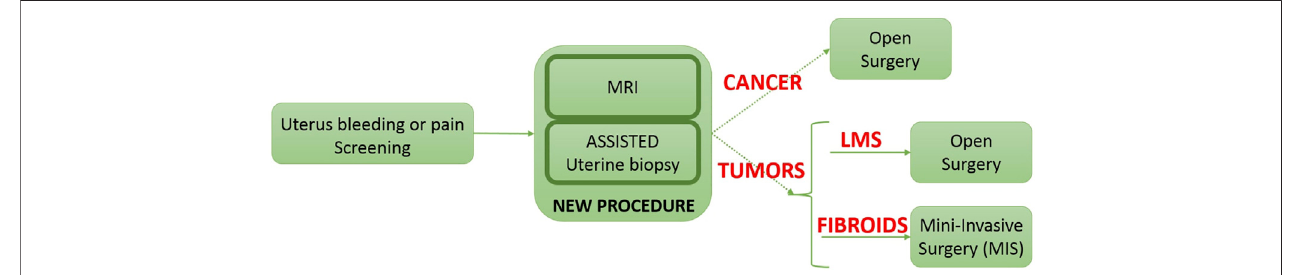
FIGURE 1 | The new procedure which is able to identify the fi broids classi fi cation.